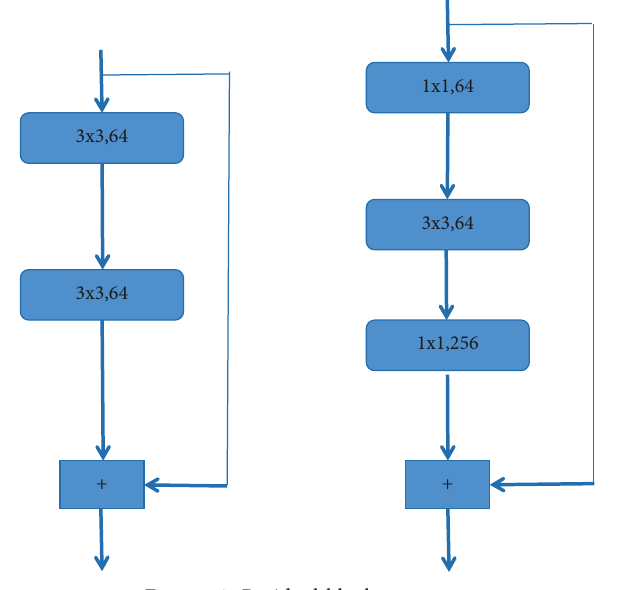
Figure 3: Residual block structure.